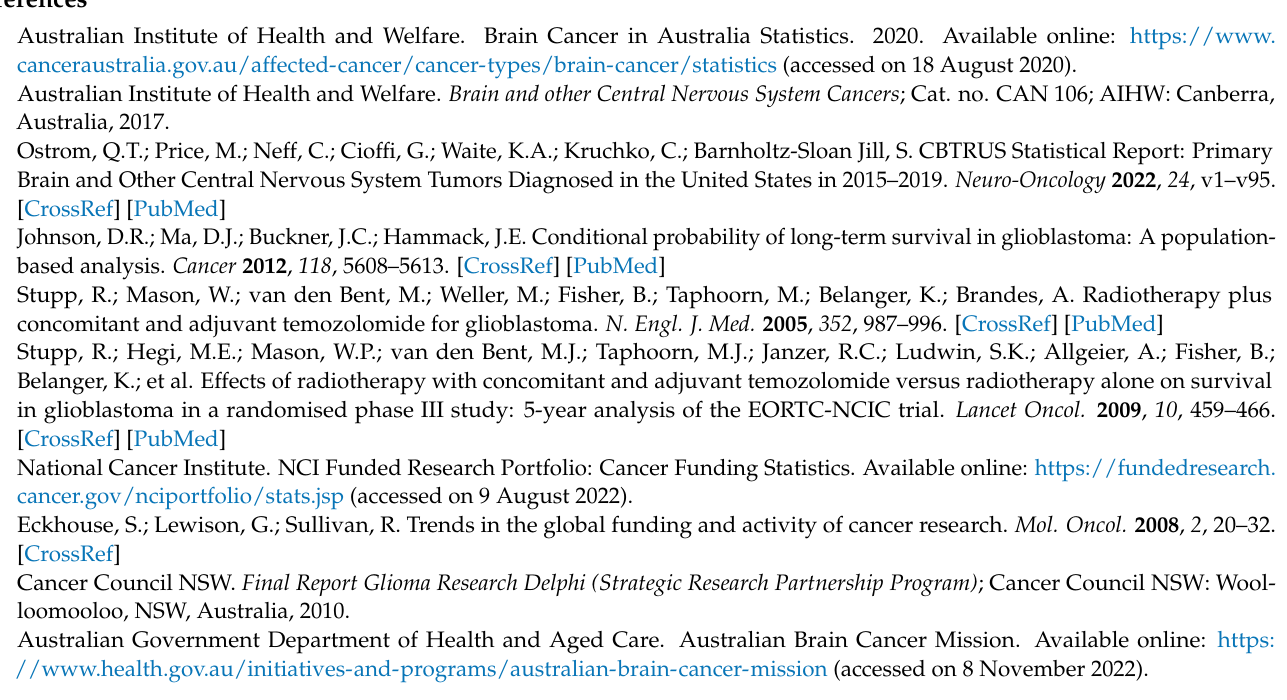
instrument; Figure S1: Radar figure of each sub-group’s ranking of the overall top fifteen priorities; Figure S2: Line graph figure of the change in overall and sub-group mean rankings of the 1st to 37th ranked priority shown in Table